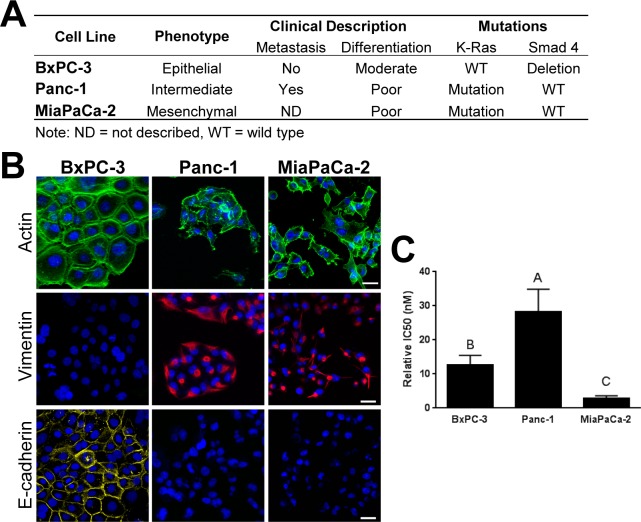
PDAC lines differ in EMT phenotype and gemcitabine resistance when cultured on 2D plastic.(A) Table summarizing pancreatic cell line phenotype, patient derivation, and relevant mutations [36]. (B) BxPC-3, Panc-1,and MiaPaCa-2 cells were cultured on 2D plastic (4x103 cells/well) for 4 days, stained for actin (green), vimentin (red), E-cadherin (yellow), and nuclei (blue), and imaged using confocal microscopy. Images represent z-stack projections (20 μm thickness; scale bar = 30 μm). (C) Gemcitabine IC50 values (mean ± SD) were determined from 10-point dose response curves for cell lines cultured on 2D plastic. Letters indicate statistically different groups (p<0.05, n = 5).